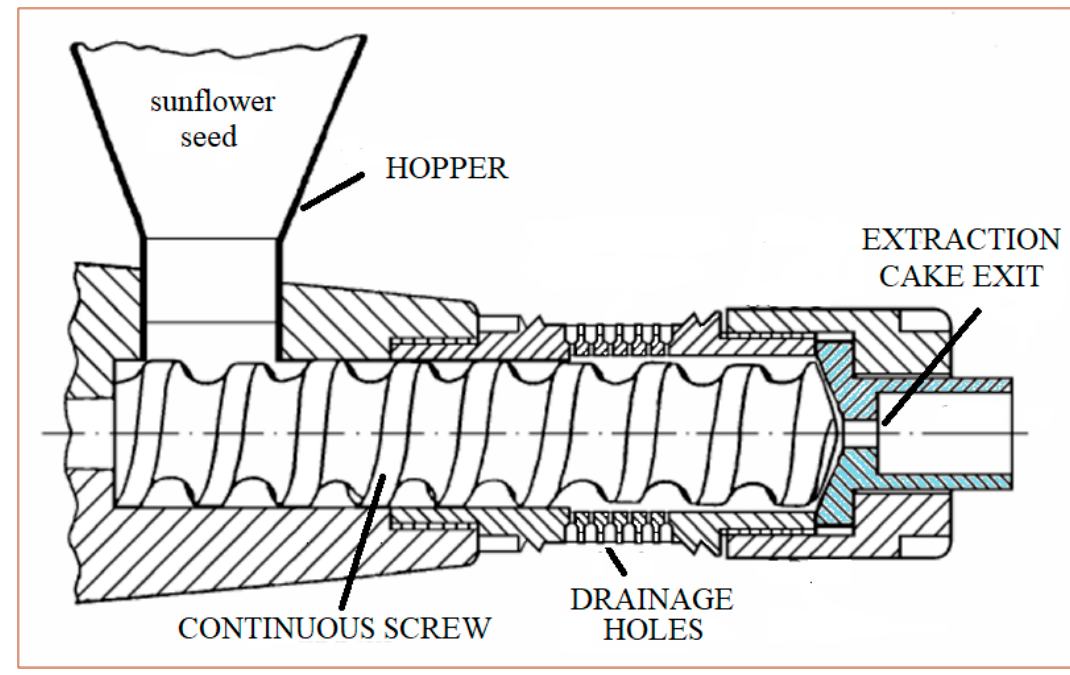
Figure 1. Scheme of the continuous screw press employed.